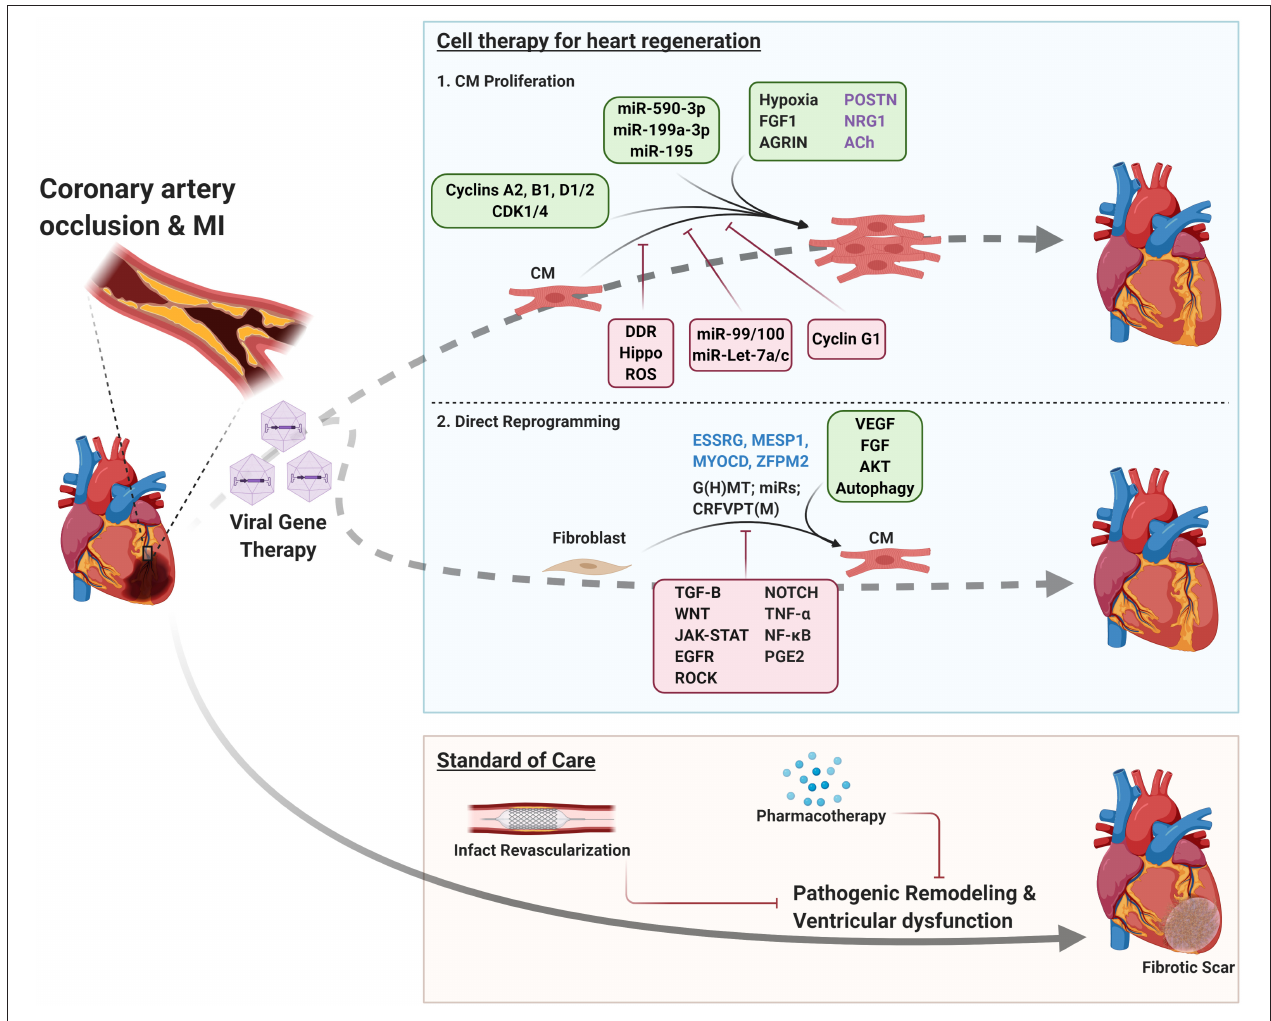
FIGURE 1 | Therapeutic strategies for ischemic heart disease. Tan box; Standard of care: Following MI, patients undergo infarct revascularization and begin pharmacotherapy to slow disease progression, but ultimately develop heart failure and progressive fibrosis. Blue box; Cell therapy for heart regeneration: schematic indicating factors that regulate CM proliferation and direct reprogramming of fibroblasts to CMs to regenerate the myocardium following MI. Green boxes indicate environmental, signaling, and genetic factors that promote CM proliferation/fibroblast reprogramming. Red boxes indicate factors that impair these processes. Factors that have conflicting reports regarding their roles in inducing CM proliferation are listed in purple text. Blue text indicates factors that enhance direct reprogramming in human fibroblasts. DDR, DNA damage response; G(H)MT, G ATA4, ( H AND2), M EF2C, T BX5; CRFVPT(M), C HIR99021, R epSox, F orskolin, V alproic acid, P arnate, T TNPB, (Rolipra m